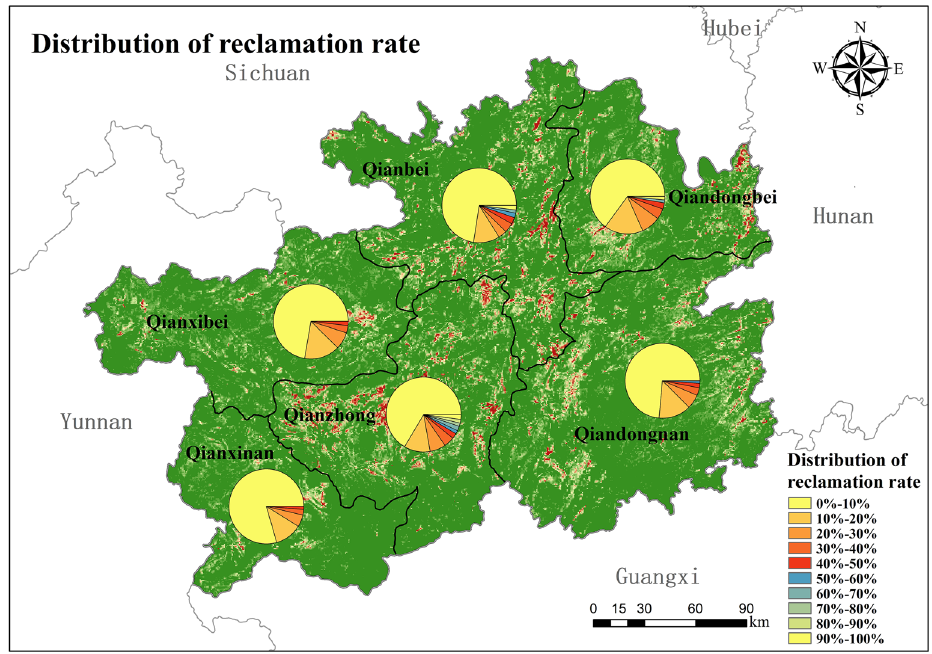
Figure 7. Percentage of settlement rate distribution intervals by district (map created using ArcGIS